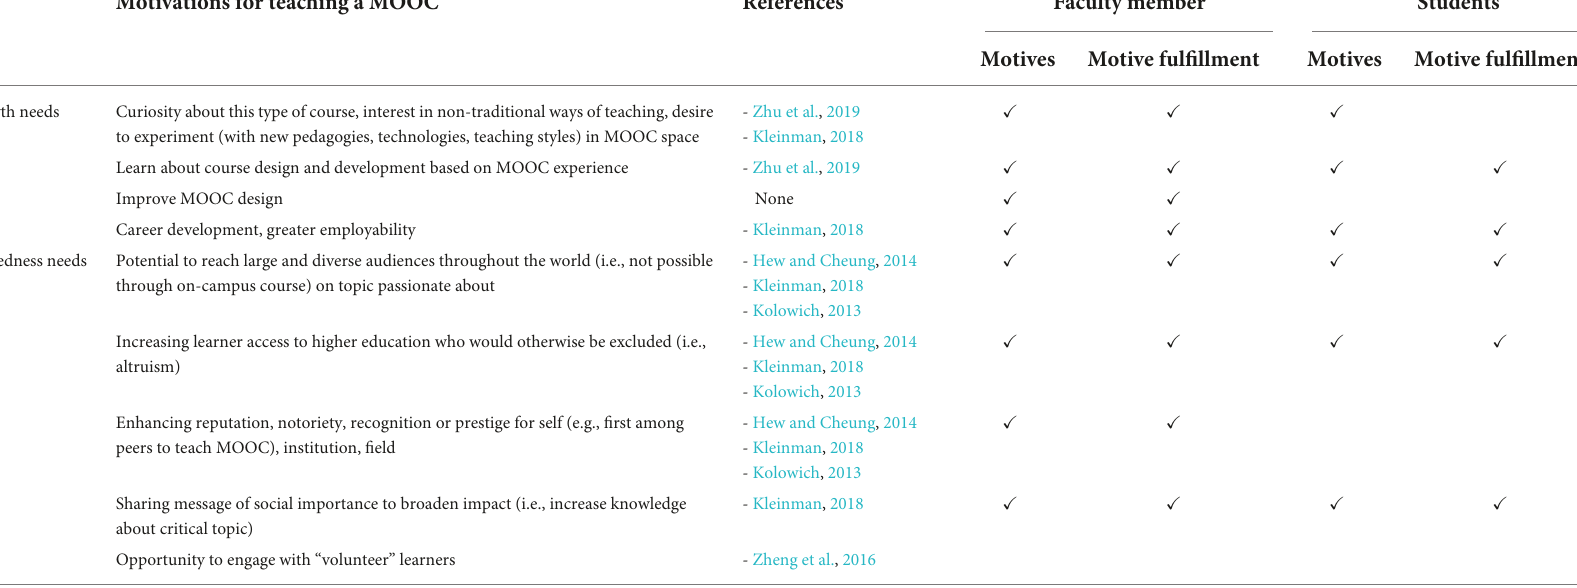
TABLE 1 Co-instructors’ motivations for developing the MOOC Act on Climate and motive fulfillment, organized by motivations identified by prior scholarship (cited in “References”